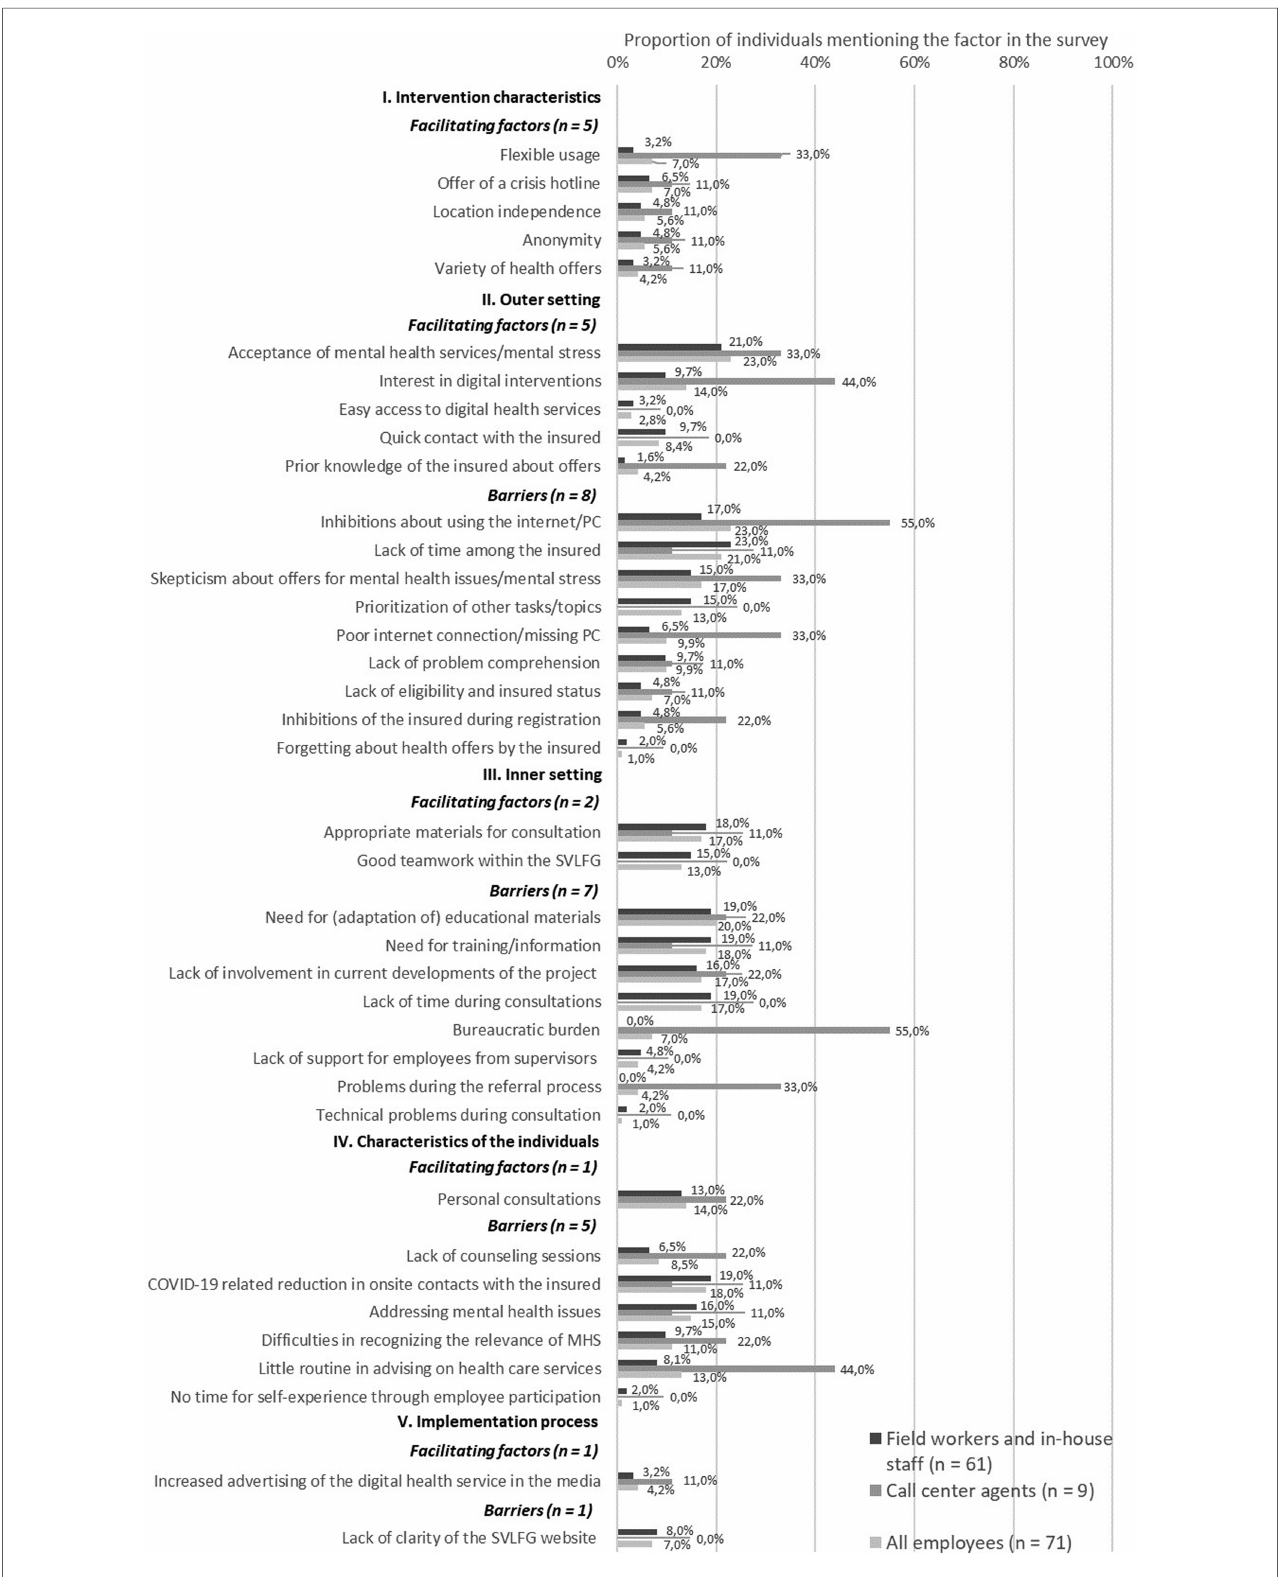
FIGURE 2 Barriers and facilitating factors from the perspective of staff involved in the referral process ( fi eld workers and in-house staff n =62; call center agents n =9), on implementation determinants based on CFIR. MHS, mental health services.